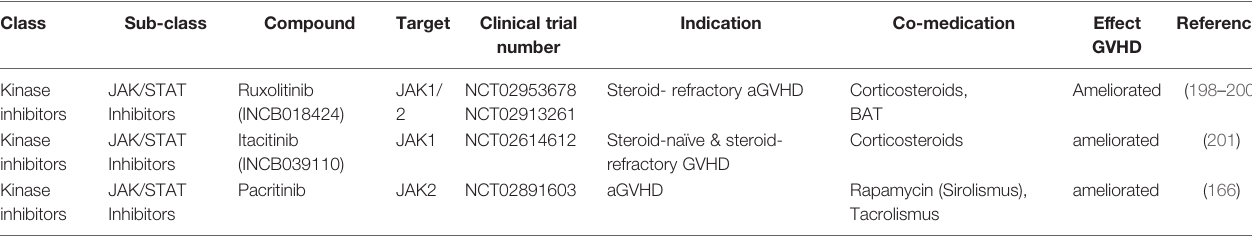
TABLE 2 | Summary of clinical trials on Th de fi ning TF